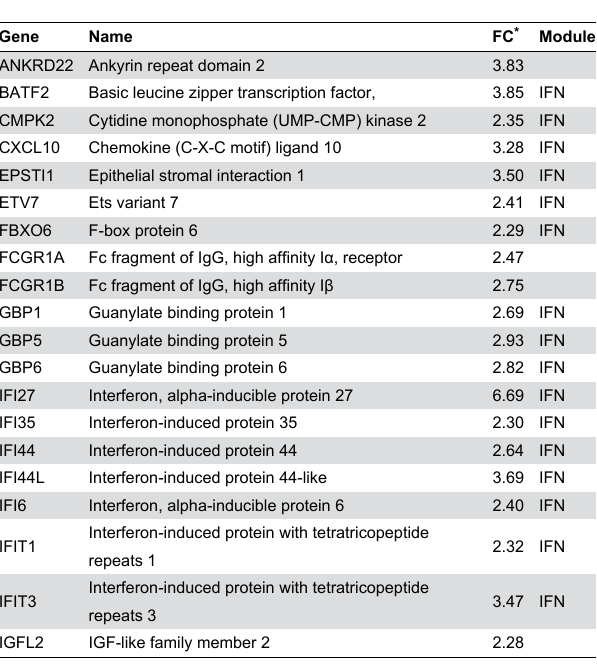
Table 5. Up-regulated genes: CVID w complications vs. CVID w/o